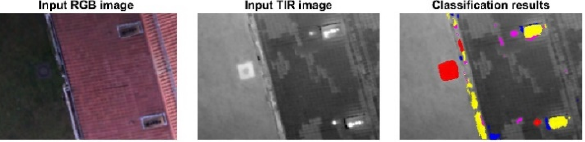
Figure 10: False classification by DST as a consequence of low contrast in the optical image